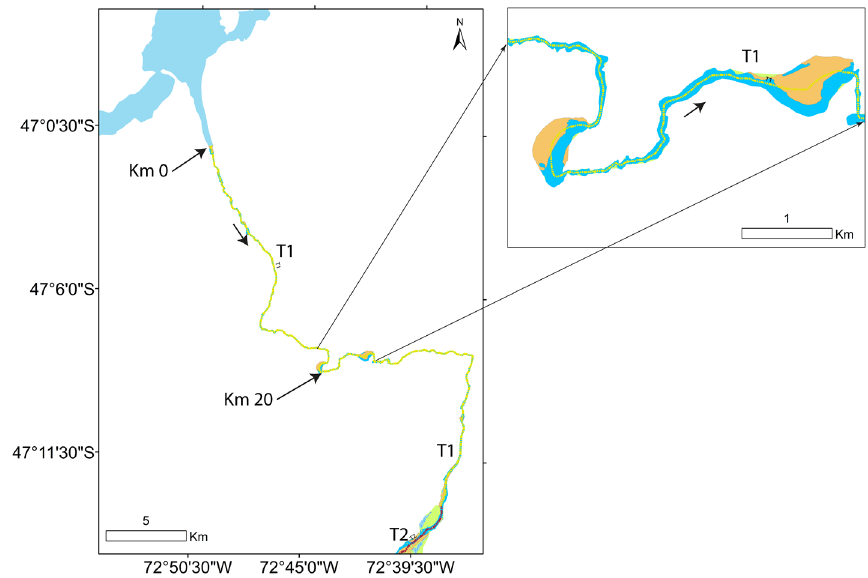
Figure 13. Baker case study: detail of the river at the major slope change (location A in the elevation profile). Location B at km 48 (Figure 12) incidentally coincides with the point where a change of planform was already established between reach T3 and T4 (see Figure 14, bottom left) and hence does not introduce any novelty.